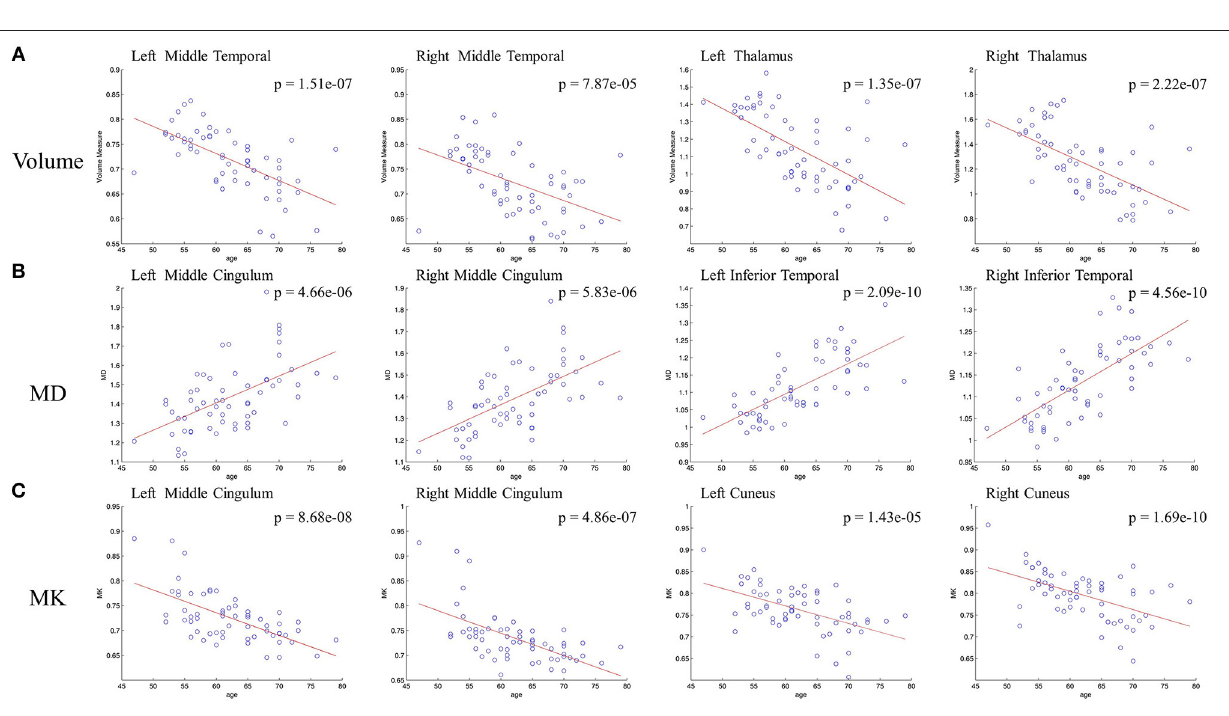
parietal lobe (bilateral precuneus, and inferior parietal gyrus), occipital lobe (bilateral cuneus and left superior occipital gyrus), temporal lobe (bilateral superior temporal gyrus, transverse temporal gyrus, fusiform gyrus and hippocampus), and subcortical nuclei (bilateral thalamus, insula, caudate nucleus, and left putamen). Scatterplots for the linear correlation